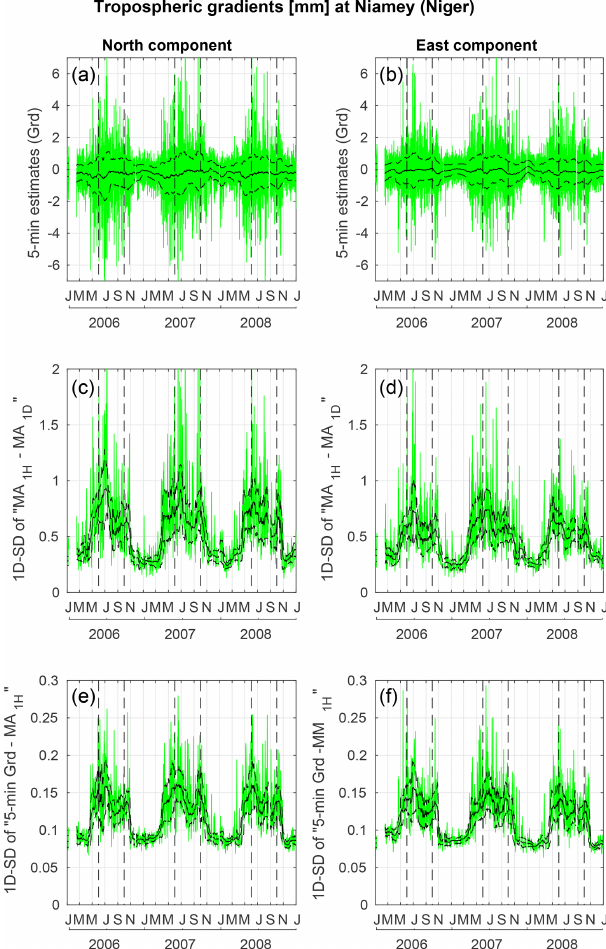
Figure 3. Analysis of the variability of GPS-derived ZWD at Ni- amey. (a) Difference between GAMIT and GIPSY-OASIS hourly ZWD estimates. (b) Sub-daily ZWD variability from GIPSY- OASIS (the daily standard deviation of the hourly minus the daily mean ZWD series is shown in green). (c) Sub-hourly ZWD variabil- ity from GIPSY-OASIS (the daily standard deviation of the 5min minus the hourly ZWD series is shown in green). The thin black solid lines in panels (a) , (b) , and (c) show the 30d moving medi- ans. The red line in panel (b) shows a 30d moving median of the sub-daily variability computed from the ZWD estimates retrieved by GAMIT. The thin black dashed lines in panels (a) and (c) show the median absolute deviations around the medians. Dashed black vertical lines indicate the JJAS period of each year.